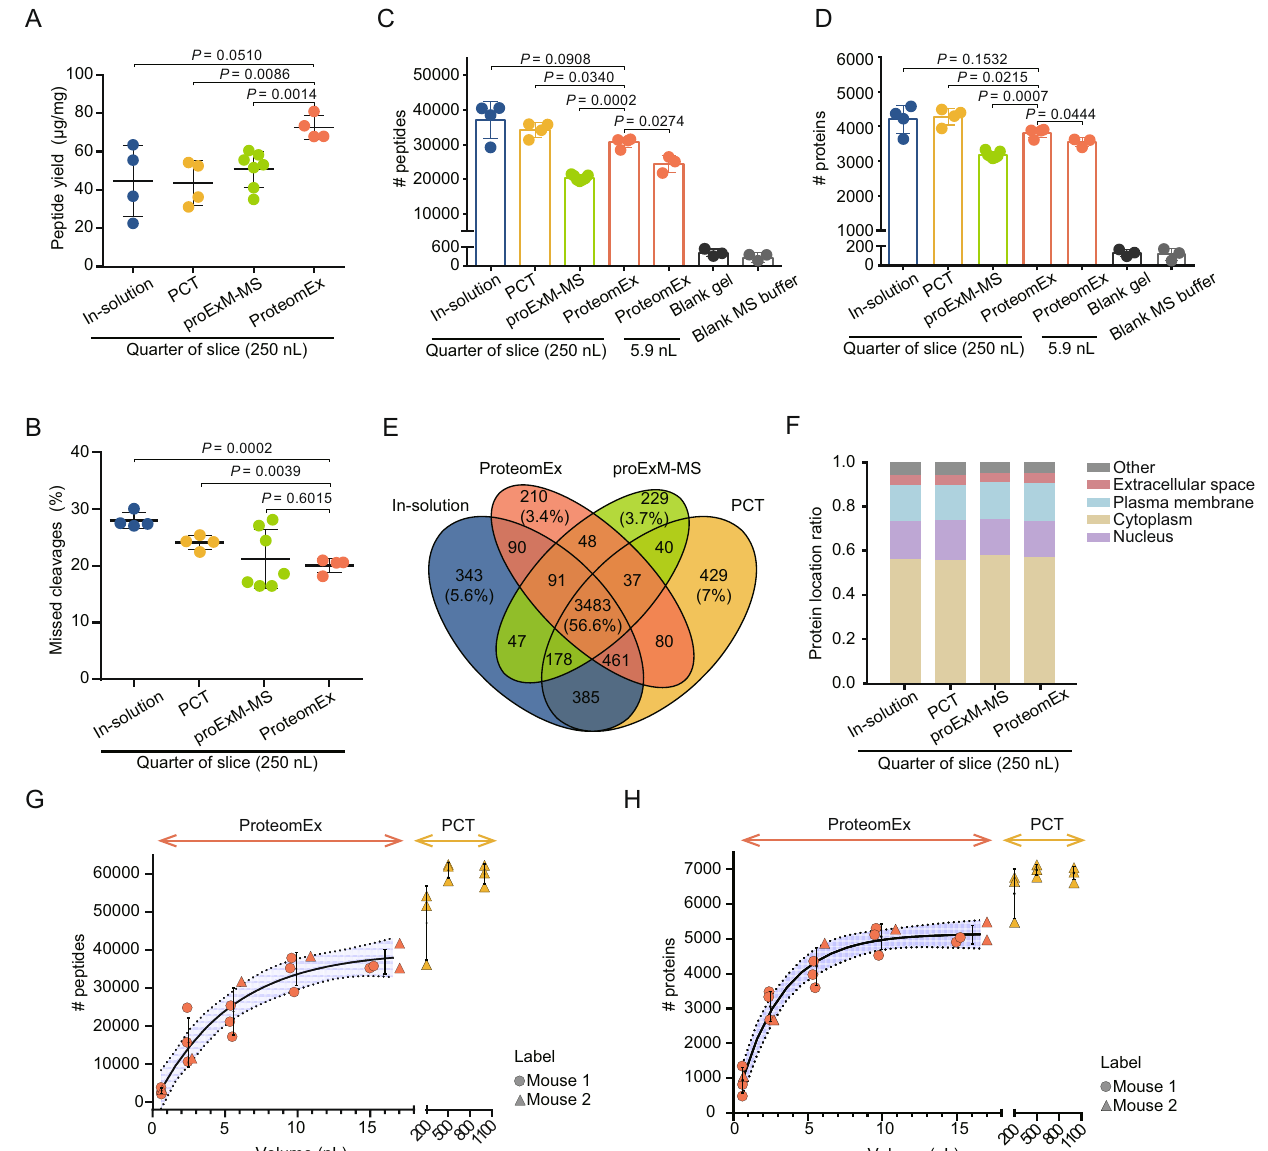
Fig. 2 | ProteomEx benchmarking. A The peptide yields of the in-solution, PCT, proExM-MS, and ProteomEx methods applied to the mouse brain tissue ( n =4, 4, 7, 4 biologically independent samples from one, one, two, and one brain slices, respectively, the same samples were used to acquire data shown in panels A – F ; dot, individual data point, bar, mean, whiskers, standard deviation (SD), throughout Fig. 2; P -values are estimated by Welch ’ s t -test (two-sided). Data are presented as mean values±SD.). B Missed cleavages of the identi fi ed peptides prepared using in-solution, PCT, proExM-MS, and ProteomEx methods. Data are presented as mean values±SD. Number of peptide ( C ) and protein ( D ) identi fi - cations in seven sample groups ( n =3 and 3 punches from one slice from one mouse for ProteomEx (5.9nL) and blank hydrogel, n =3 independent injections